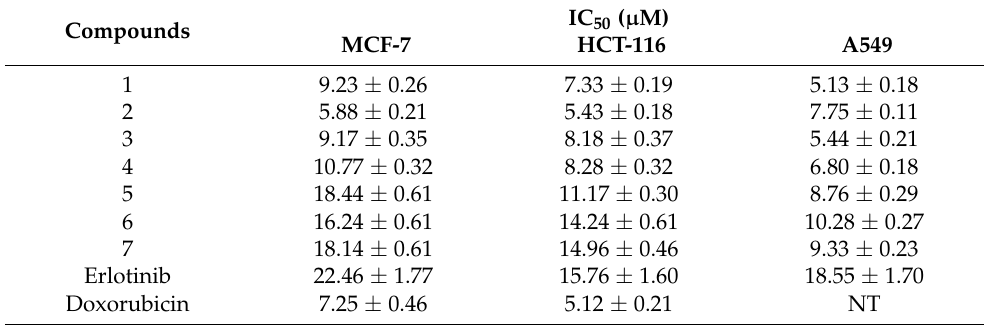
Table 3. In vitro antiproliferative activities of compounds 1 – 7 against MCF-7, HCT-116 and A549 cells.